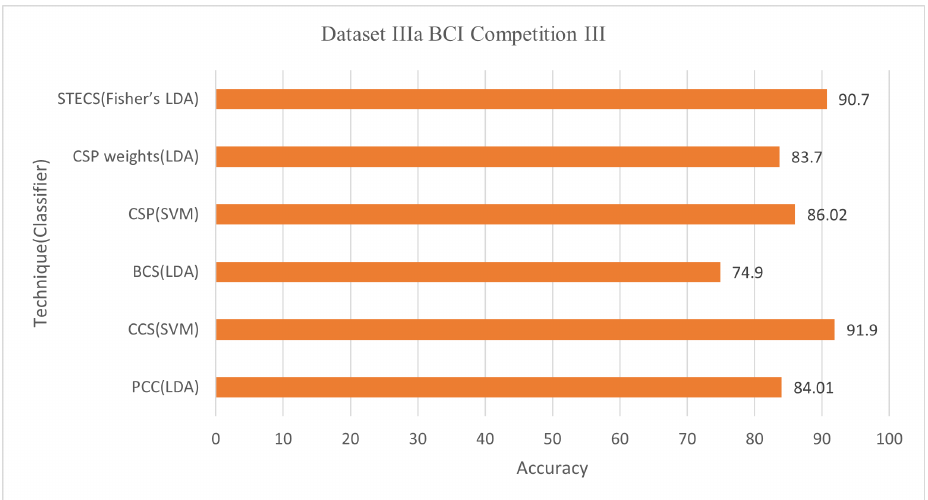
Figure 9. Accuracy by different techniques for Dataset IIIa BCI Competition III.